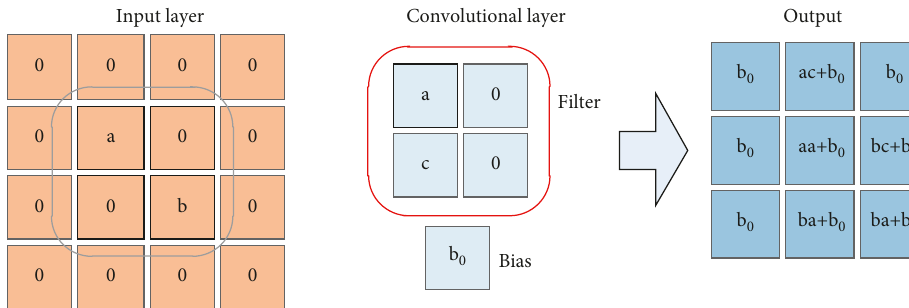
Figure 3: Process of the convolution